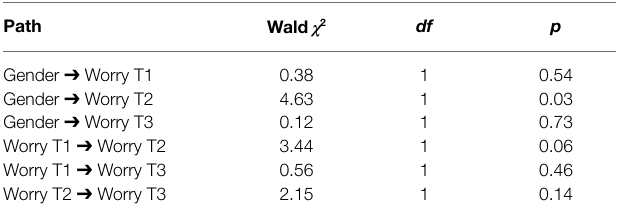
N = 102. T1/T2/T3 = first/second/third measurement times.